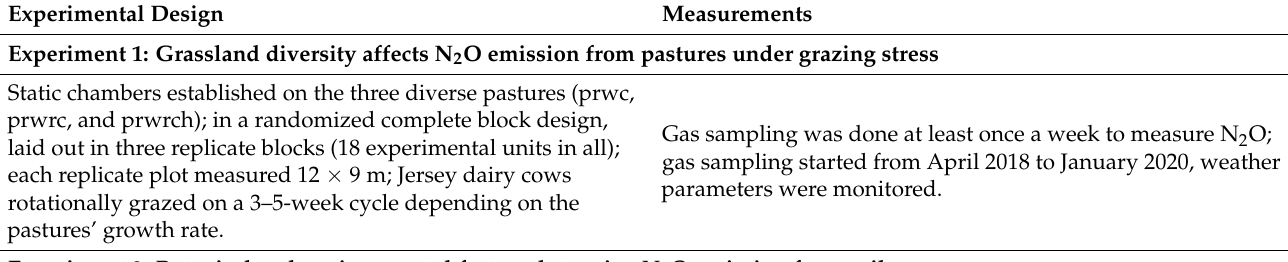
Figure 1. Weather parameters and water-filled pore space (WFPS) during the experimental period. Blue (broken) lines demarcate the experimental years; non-irrig: Non-irrigated; irrig.: Irrigated. Table 1. Summary of the experimental designs and measurements. Experimental